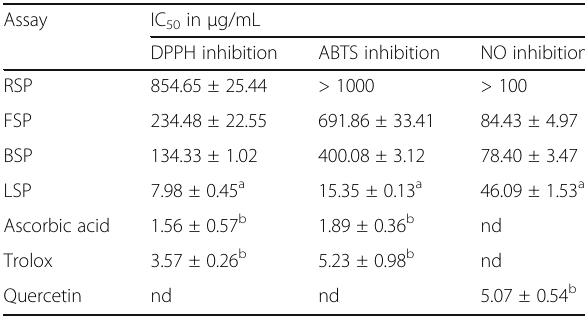
Table 2 Inhibitory concentration (IC 50 in μ g/mL) of extracts from roots, fruits, bark and leaves of Sarcocephalus pobeguinii and positive controls (trolox and ascorbic acid) or quercetin